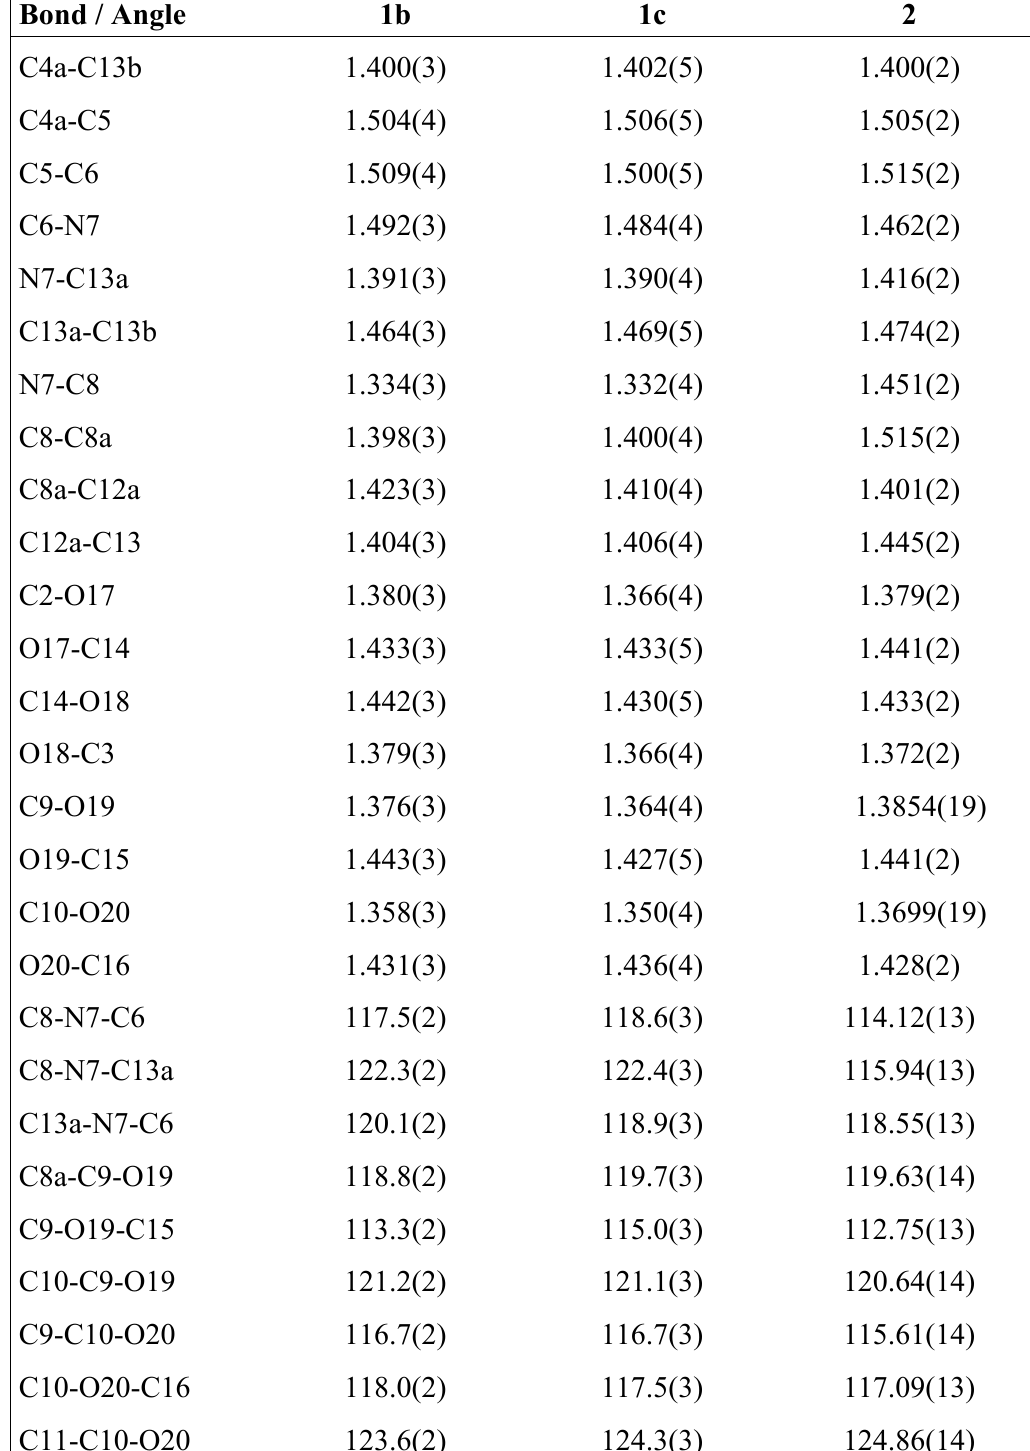
Table 2. Selected geometric parameters of compounds 1b , 1c , and 2 (Å, º) Bond /